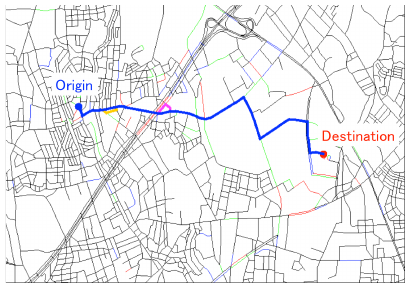
Figure 12. K-shortest routes (K=3) in Chiba Table 2. Cover rate and average of total length of the result in Chiba